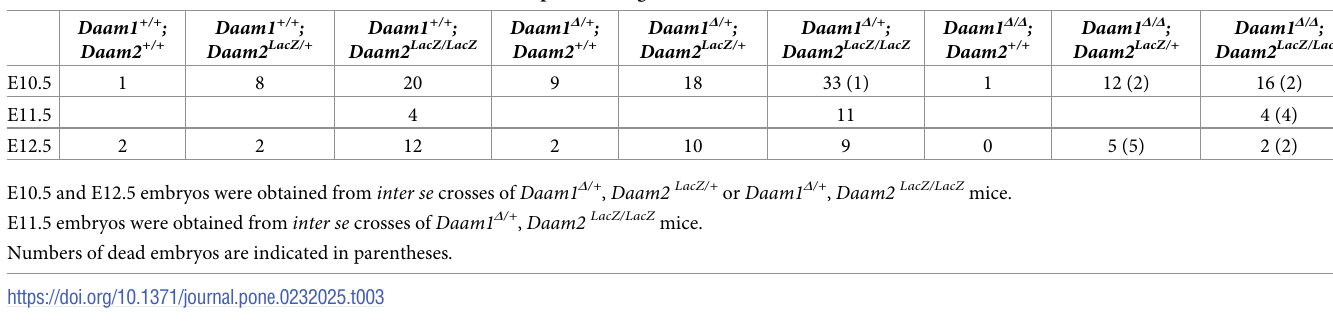
severe and occured earlier (E10.5) in the double mutants than in the single Daam1 Δ / Δ placentas (E12.5) (Figs 2C’ and 2D’ and 3E‘–3G’), we conclude that Daam1 and Daam2 have redundant functions in placental development. Table 3. Number of Daam1 and Daam2 mutants for each developmental stage. Daam1 +/+ ; Daam2 +/+